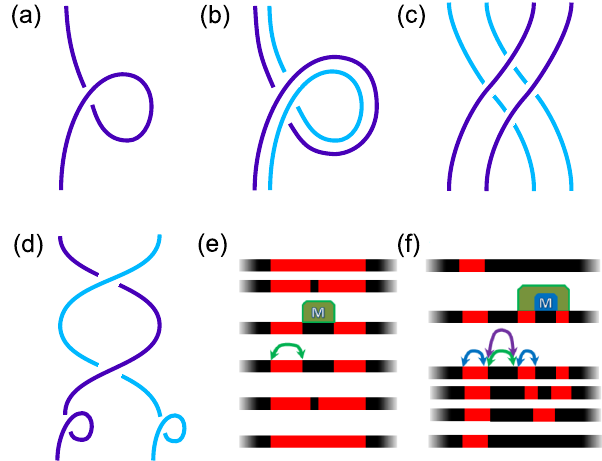
FIG. 4. Topological spin. The process illustrated in (a) defines the TS, where the curves represent the world lines of the X or q particles. A curve forming a cup [ corresponds to creation of a particle–antiparticle pair (two X ’s fusing to q ¼ 0 or two charges þ q ¼ 0 ), and a curve forming a cap \ corresponds to with q 1 2 projection onzero total charge.(b)TSofa compositeobject.When both lines are labeled by X and fuse to charge q , the phase acquired . The fourfold crossing, which is magnified in (c), is assumed is (cid:8) q toresultinanexchangeoftwo q ’s.Whenthelinesarelabeledby q 1 and q , the phase acquired is (cid:8) . Importantly, the TS of a q 1 þ q 2 mod 2 m 2 composite is equal to the phase accumulated in the process appear- ing in (d). This equality results from using the Yang-Baxter equation and the definition of the TS. (e) The evolution of the . The green arrow different segments in the process defining (cid:8) X corresponds to braiding, while the M corresponds to projection on . The braids (arrows) are zero charge. (f) The process defining (cid:8) q ordered by color: green, blue, and finally purple. The projections are on zero spin for the magnet segment intersecting the two SC segments and zero total charge for these two